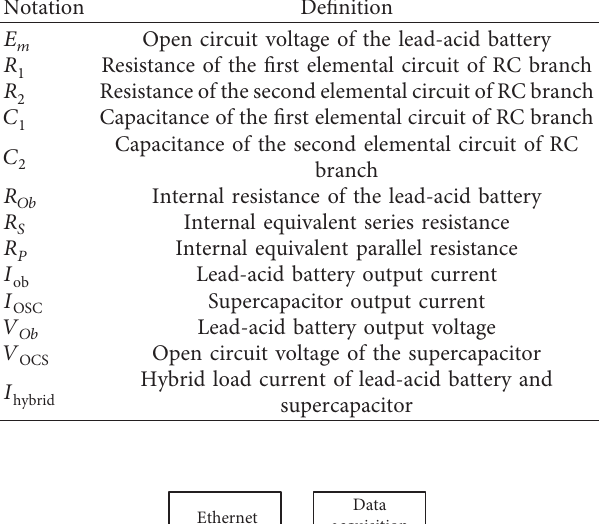
Table 2: Summary of notations and definitions.